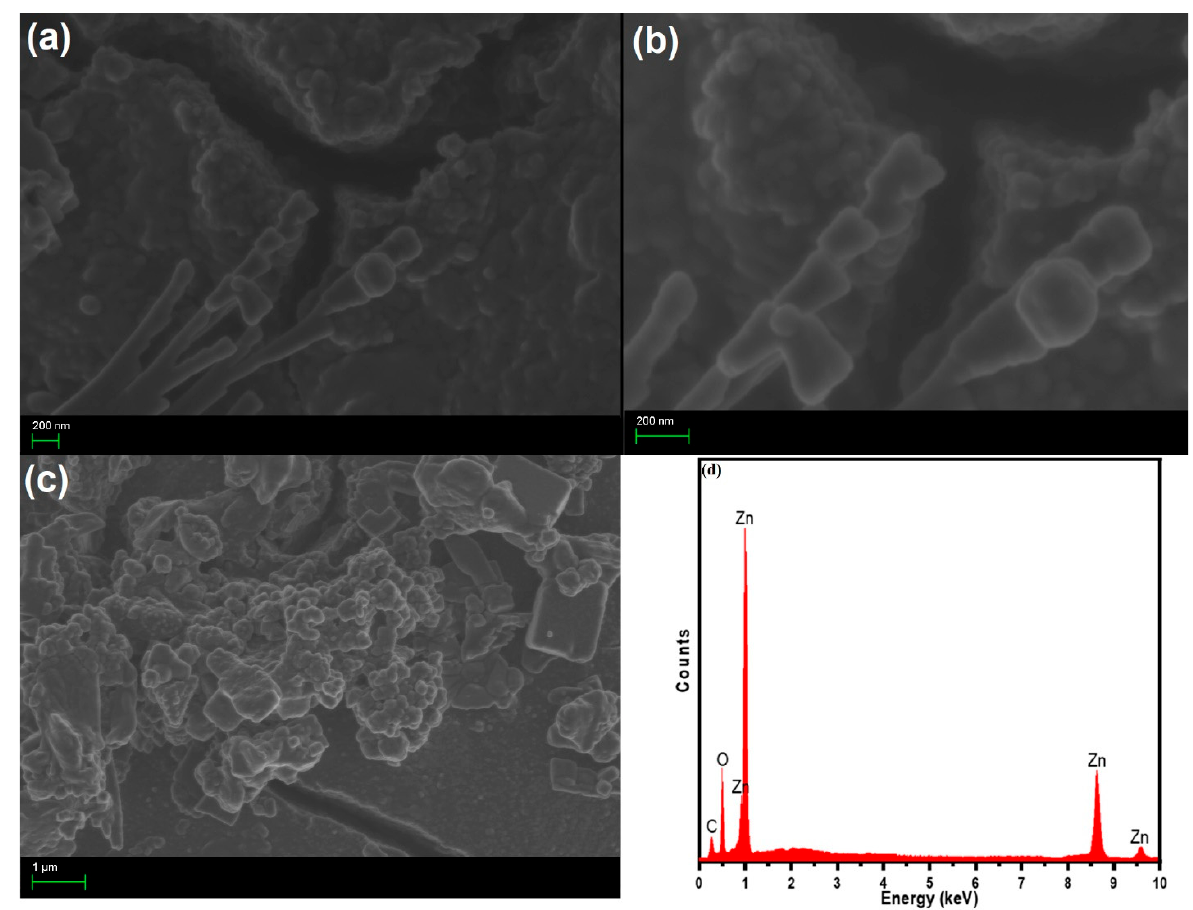
Figure 9. ( a – c ) SEM images and ( d ) EDX spectra of LP-ZnO NPs.